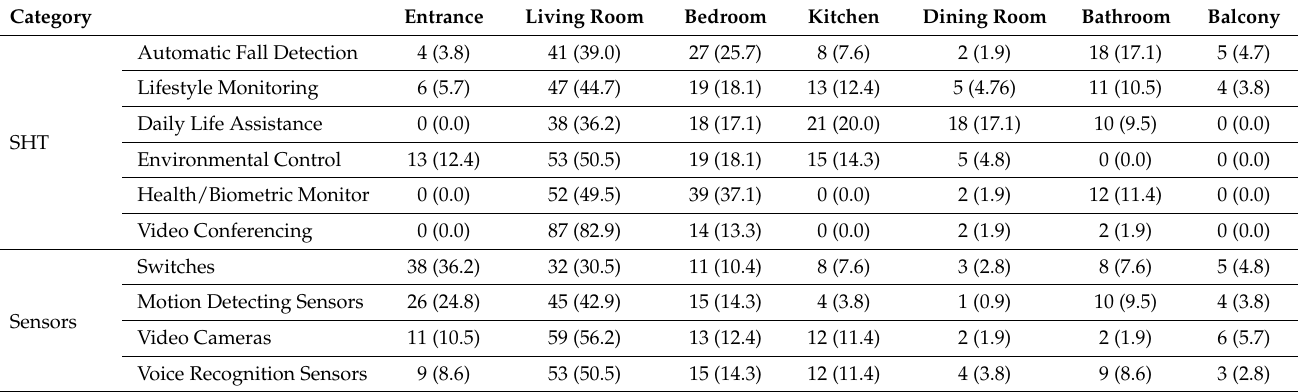
Table 9. Location of Smart Home Technology and Sensors.